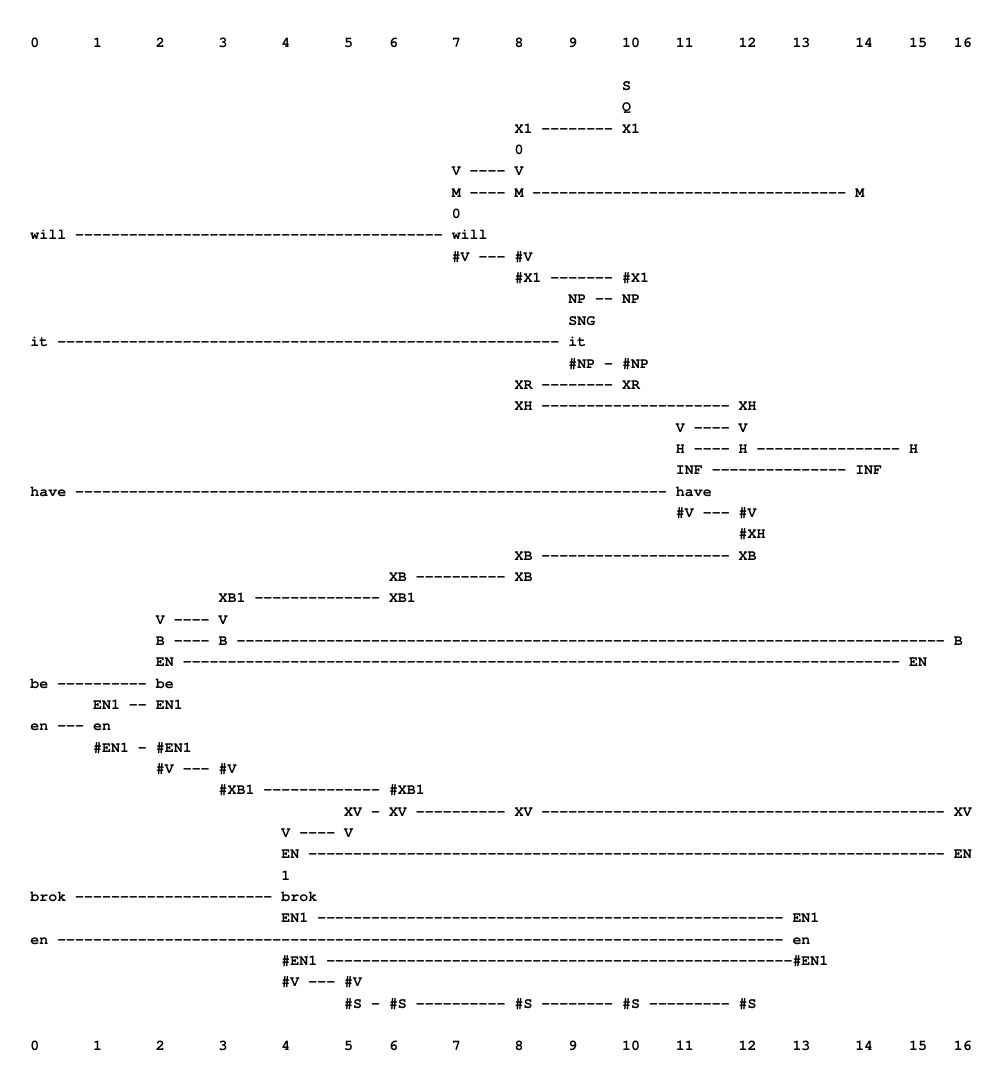
Figure 14. The best alignment found by the SP model with “ will it have be en brok en ” in New (column 0) and the same grammar in Old as was used for the example in Figure